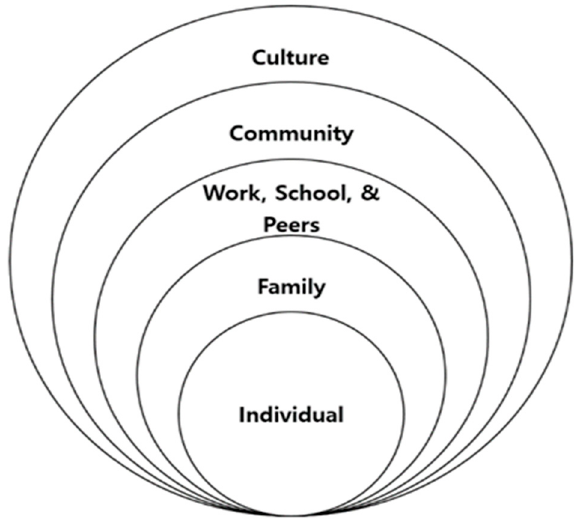
Figure 1. Modified socioecological system theory (Adapted form Bronfenbrenner [19]).